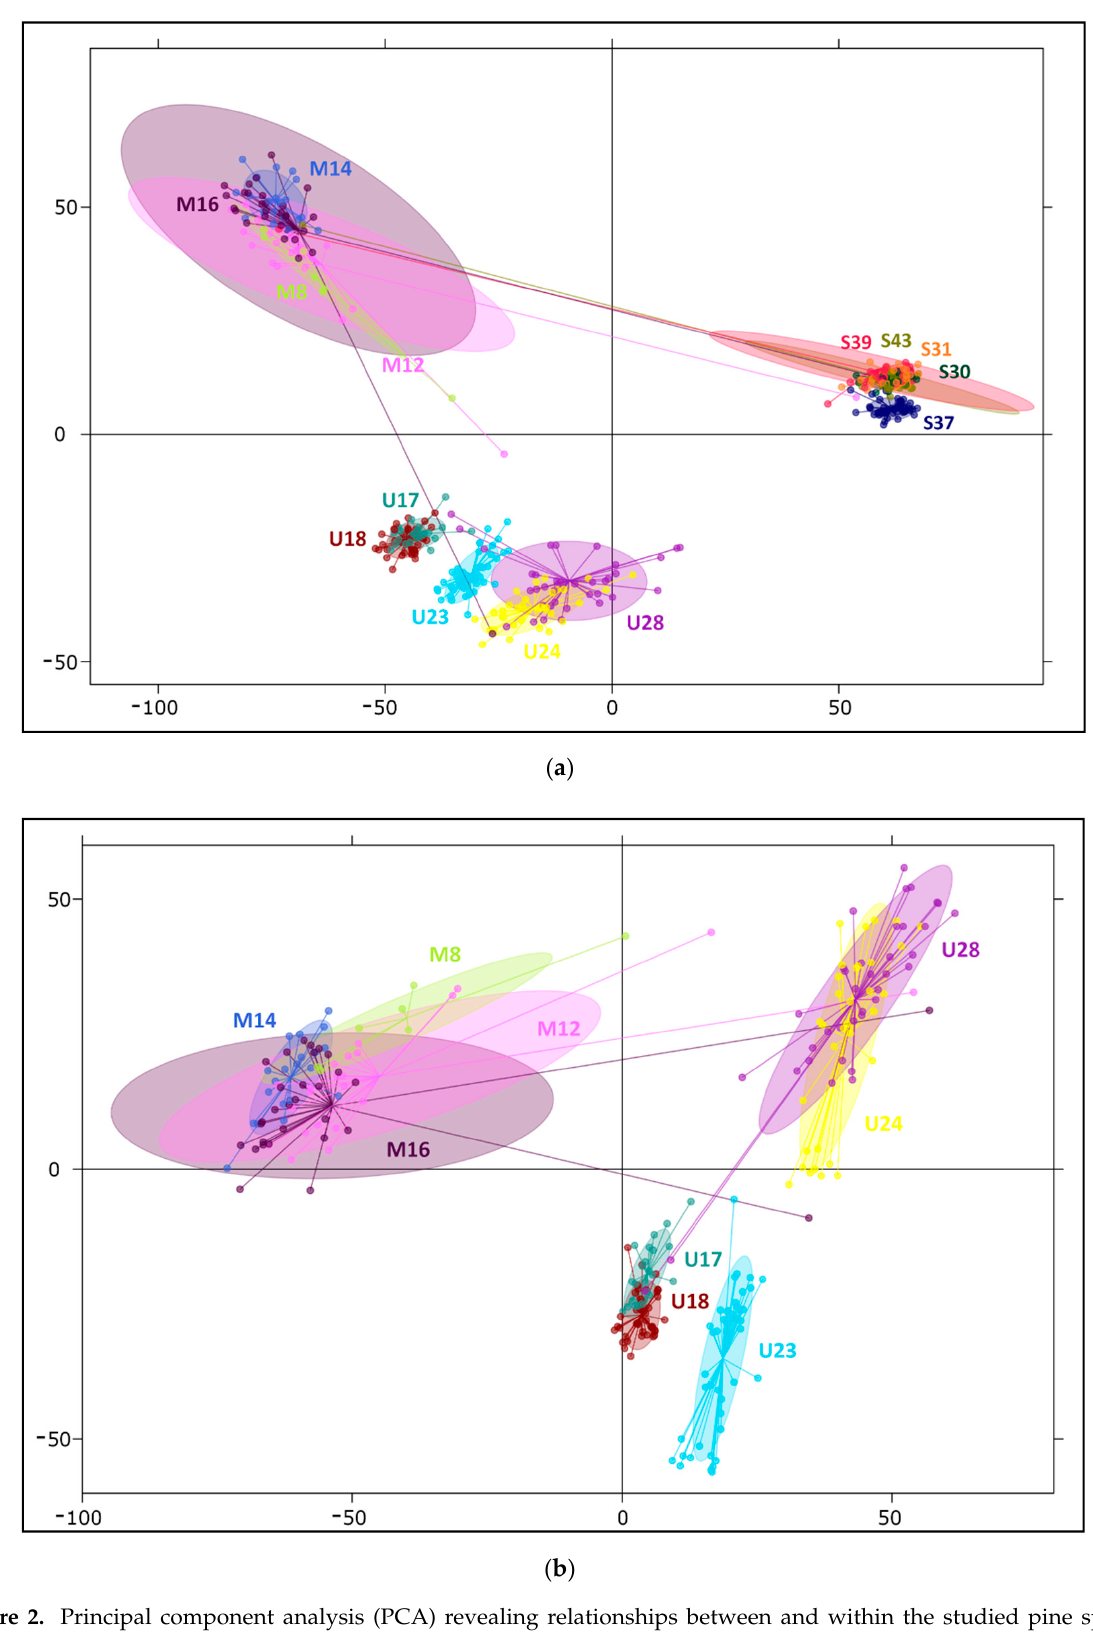
Figure 2. Principal component analysis (PCA) revealing relationships between and within the studied pine species. ( a ) Division of the three investigated taxa, first and second coordinates (horizontal and vertical axes, respectively) correspond to 12.3% and 3.5% of variation; ( b ) separation of two mountain species with 6.6% of variation explained by the first and 3.4% by the second component. Ellipses indicate 95% confidence intervals.